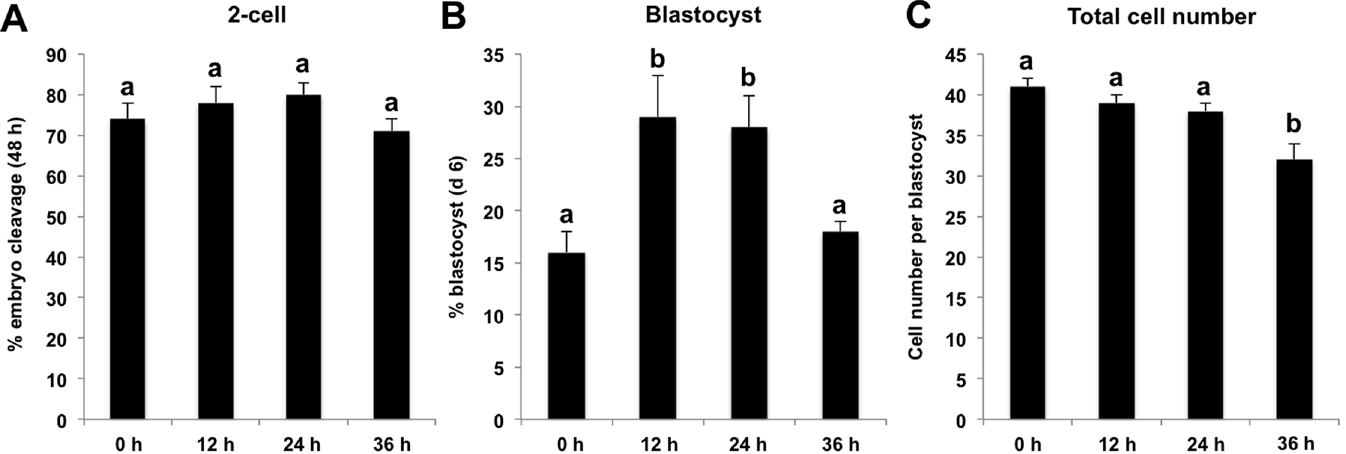
Fig 2. Effect of 0.5 nM EPZ treatment with different durations on developmental efficiency of porcine SCNT embryos. Porcine SCNT pronuclear stage embryos were cultured in PZM-3 medium supplemented with 0.5 nM EPZ for different durations, namely 0 (n = 97), 12 (n = 97), 24 (n = 88) and 36 h (n = 100). The numberof 2-cell (48 h after activation, n = 72, 76, 70 and 70) (A) , blastocysts (day 6 after activation, n = 16, 27, 25 and 18) (B) and total cell numberper blastocyst (n = 16, 27, 25 and 18) (C) were recordedand statistically analyzedby SPSS software. The experimentwas repeatedfour times for each group. Data are expressedas mean ± S.E.M. Values with different superscripts across treatments indicate significantdifferences ( p < 0.05).